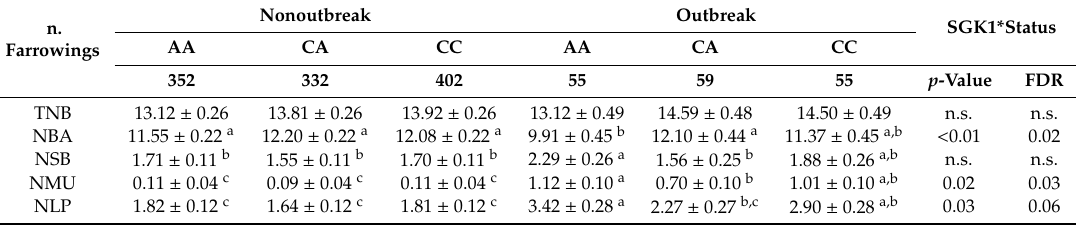
Figure 2. Least square means by PRRSV health status for the percentage of lost piglets per litter by SGK1_rs338508371 ( a ), TAP1_rs1109026889 ( b ), and TAP1_rs80928141 ( c ) genotypes. Error bars represent standard errors. Within markers, means with different letters differ significantly ( p < 0.05). Table 3. Least square means ( ± SE) for reproductive traits by SGK1_rs338508371 genotype and farm health status. Significant interactions between genotype and the health status of the farm (SGK1*Status) are indicated.